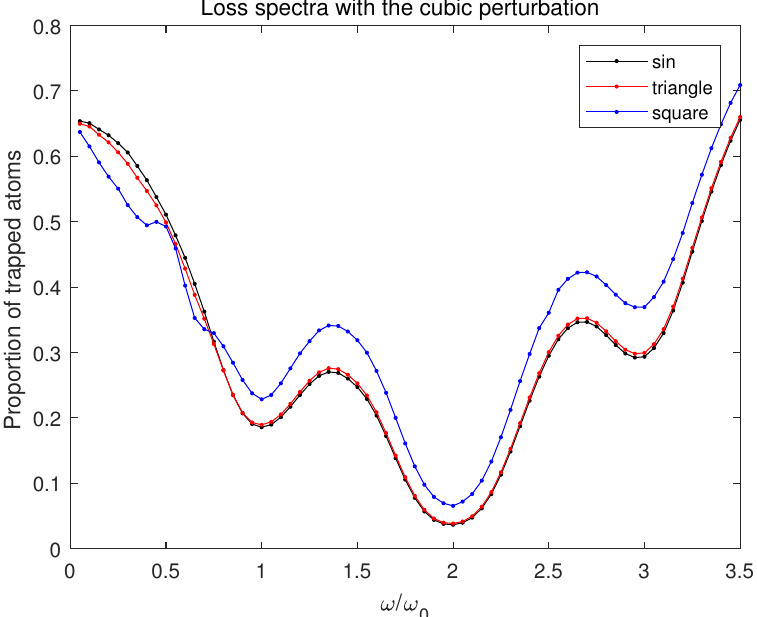
Figure 5. Decimal logarithms of the simulated population of the lowest level vs. the relative frequency ω / ω 0 of the modulation signal at the instant t = 50 ms, within the model described above: black—the sinusoidal modulation signal, red—the triangular modulation signal, blue—the square modulation